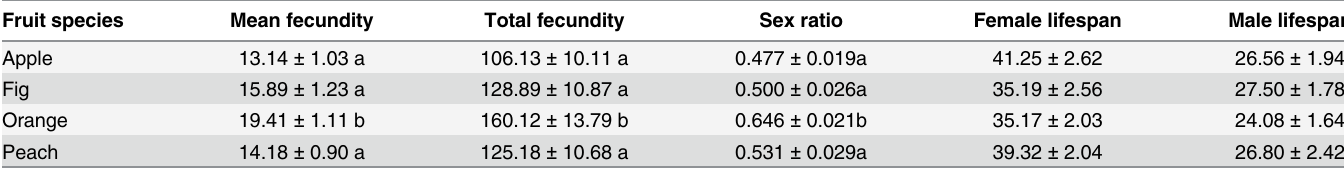
Means followed by the same letter within the same column do not differ statistically ( α = 0.05; multiple